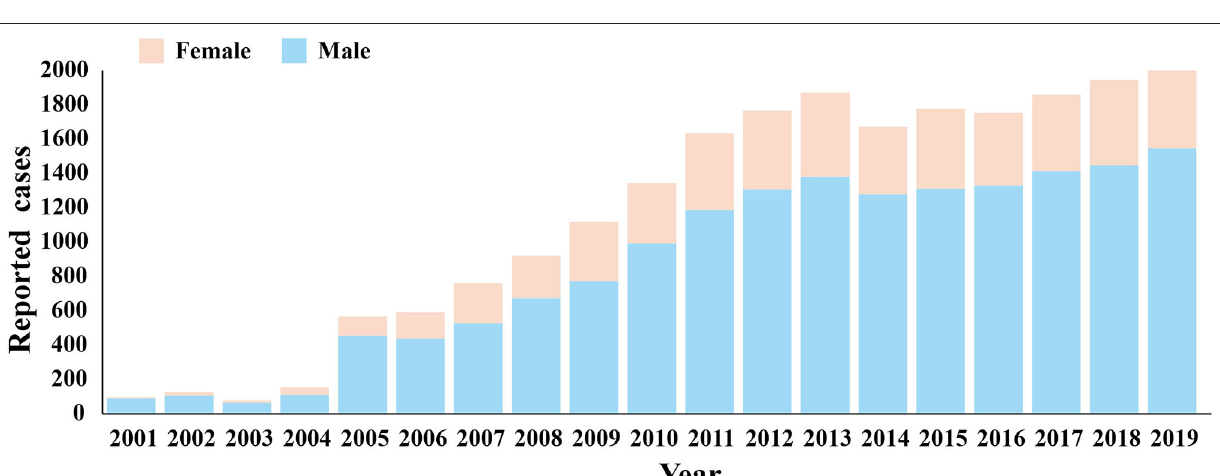
FIGURE 4 | The distribution by place of HIV in Nanning for 20 years (The signal of the red point represents the site of Nanning city in China).